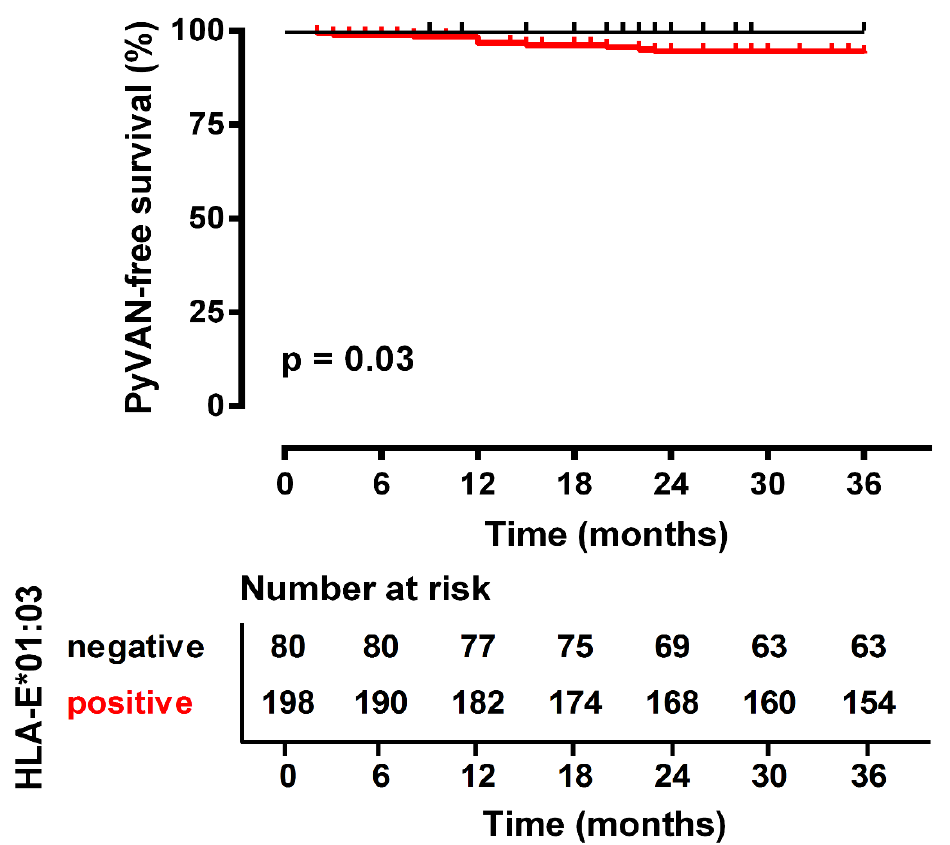
Figure 1. Association between the PyVAN-free survival and the HLA-E*01:03 carrier status of the transplant recipient during the first three years after living-donor kidney transplant. Recipients carrying the HLA-E*01:03 allelic variant were significantly more susceptible to develop PyVAN.